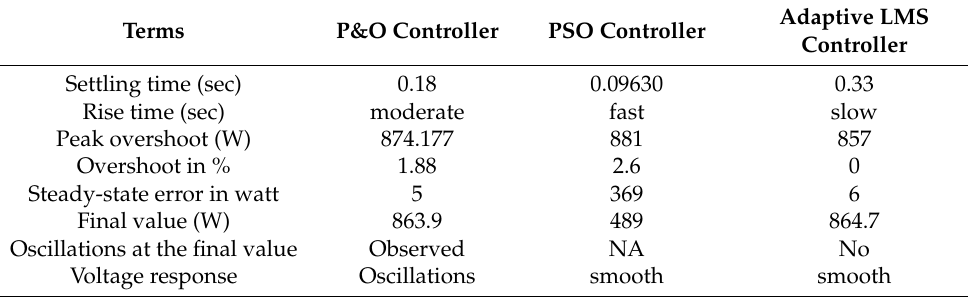
Table 11. Transient and steady-state performance of the MPPT